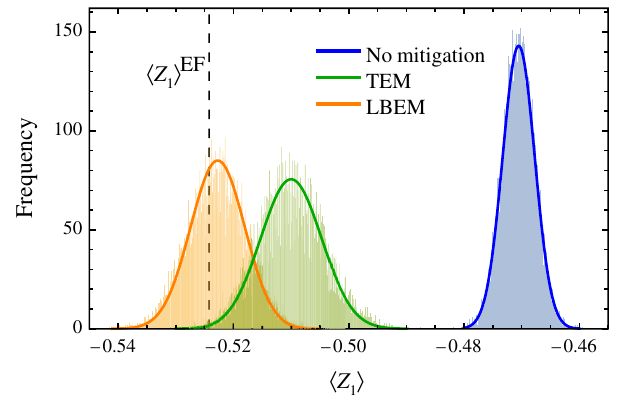
FIG. 5. Expectation values of (cid:10) Z 1 (cid:2) obtained from a single experiment repeated 10 000 times with no error mitigation (blue), tomography-based error mitigation (green), and learning-based error mitigation (orange). Dashed line indicates an error-free expectation value (cid:10) Z 1 (cid:2) EF . The solid lines describe analytically derived probability distributions for each